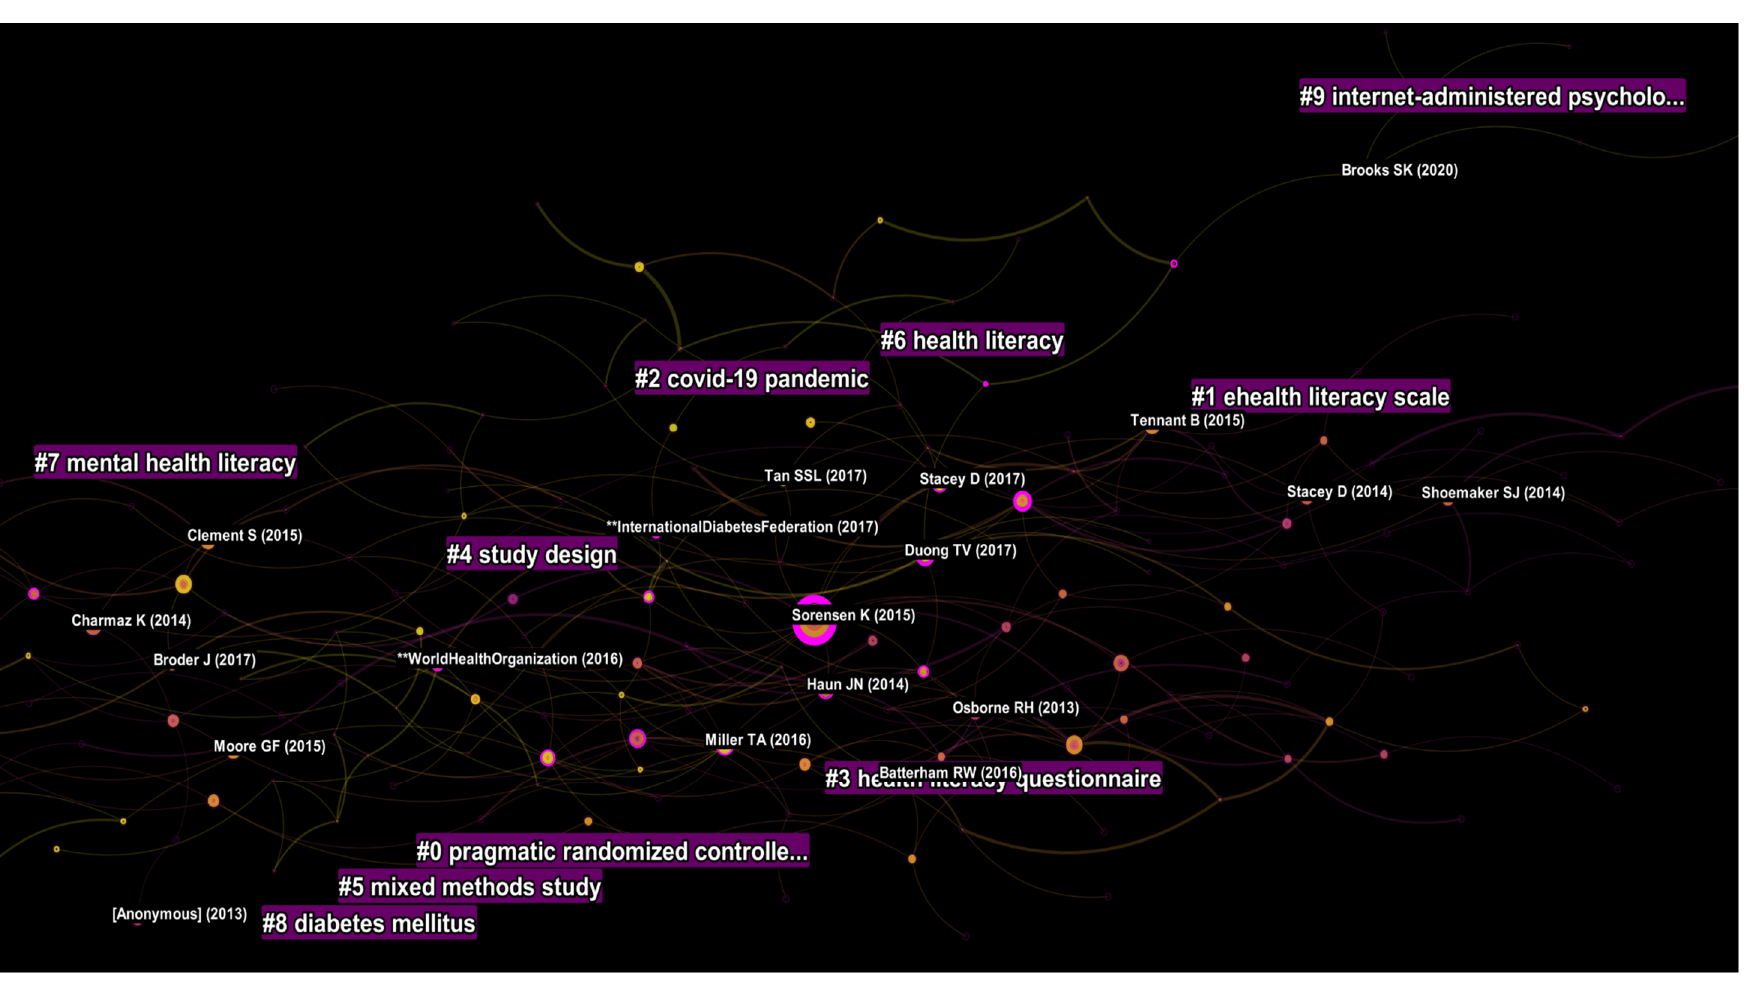
Figure 8. Top clusters published from 2017 to 2021.